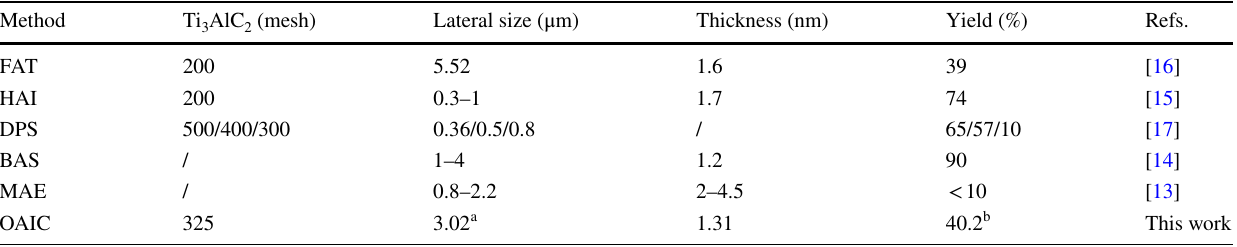
Table 1 Comparison of the lateral sizes, thickness, and yield of O-Ti 3 C 2 T x products by OAIC approach with other reports